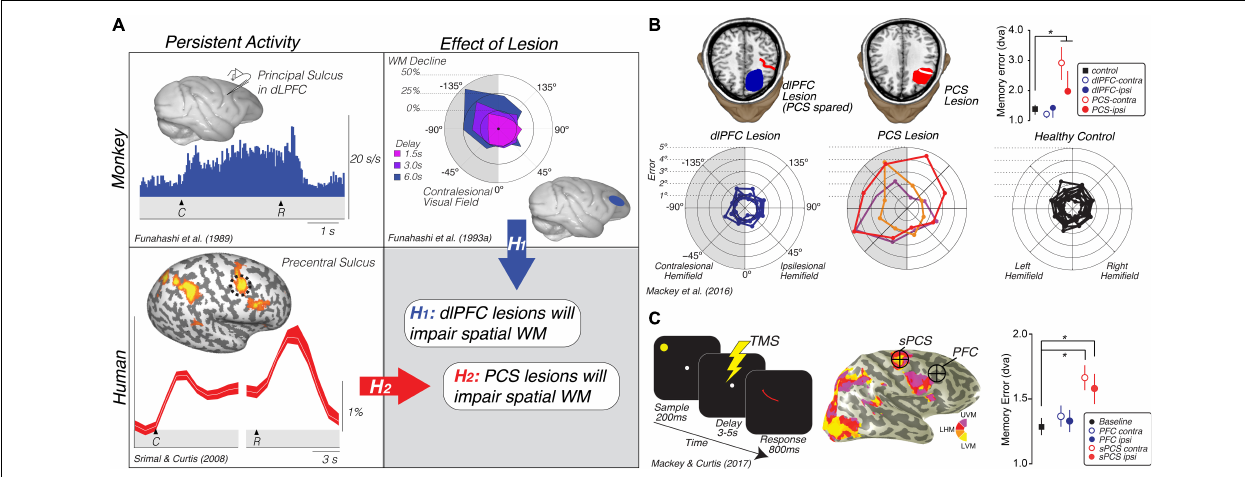
FIGURE 2 | Translating the canonical model of WM to humans. (A) Rationale and hypotheses of studies of lesion (Mackey et al., 2016b) and TMS perturbation (Mackey and Curtis, 2017) of human PFC. Neural activity persists in the monkey dlPFC during the retention interval of memory-guided saccade tasks (Funahashi et al., 1989). Lesions to the monkey dlPFC cause impaired memory-guided saccades, especially when made into the visual field contralateral to the lesion (Funahashi et al., 1993a). Hypothesis 1: These monkey data predict that lesions to human dlPFC will impair spatial WM performance, including the accuracy of memory-guided saccades. However, human neuroimaging studies typically find persistent activity or multivoxel decoding of information restricted to the PCS, posterior to the likely homolog of the monkey principal sulcus in the dlPFC (Courtney et al., 1998; Srimal and Curtis, 2008; Jerde et al., 2012; Sprague et al., 2014; Hallenbeck et al., in press; Li et al., in press). Hypothesis 2: These data predict that lesions to human PCS, not dlPFC, will impair WM performance. (B) Human PCS lesions, but not dlPFC lesions, impact spatial WM (Mackey et al., 2016b). Plot in the upper right depicts the mean (SEM) of memory errors assessed by measuring the accuracy of memory-guided saccades when the memory targets were in the visual hemifield contralateral and ipsilateral to the lesion. The radial histograms show the spatial distribution of errors highlighting that the PCS lesions primarily impact memory-guided saccades to the contralesional hemifield, as in Funahashi et al. (1993a). Colors help identify each patient. (C) TMS applied during the middle of the delay period of a memory-guided saccade task to the retinotopically defined superior PCS, but not to dorsolateral PFC, induces errors in the accuracy of memory-guided saccades (Mackey and Curtis, 2017). Plot in the lower right depicts the mean (SEM) of memory errors assessed by measuring the accuracy of memory-guided saccades when the memory targets were in the visual hemifield contralateral and ipsilateral to the hemisphere in which TMS was applied. UVM, upper vertical meridian; LHM, left horizontal meridian; LVM, lower vertical meridian. *Denotes statistically significant